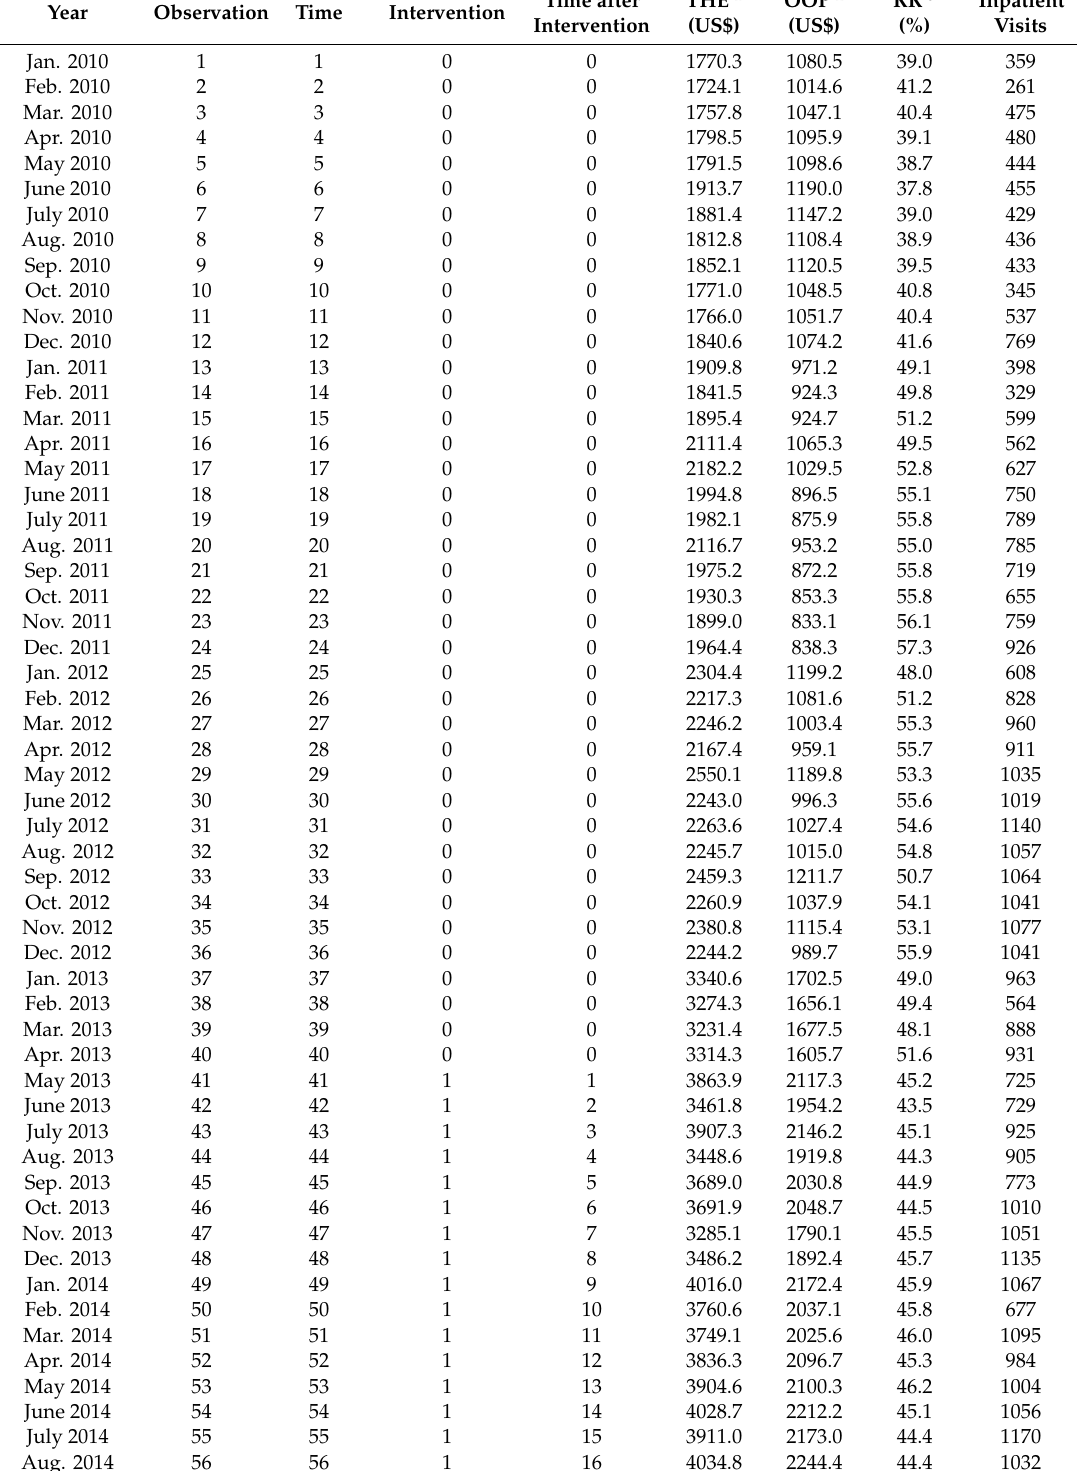
Table A1. Detailed information of interrupted time series (ITS) analysis, medical expenses and medical services